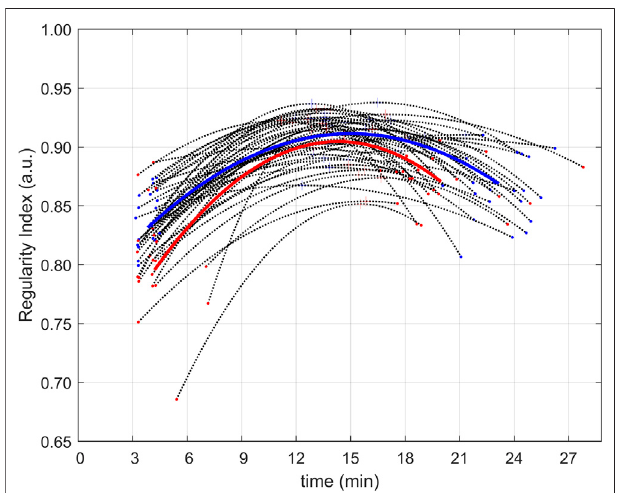
FIGURE 2 | Regularity pro fi les of all subjects. Regularity pro fi les (computed as second-order polynomials fi tting experimental data) for the 45 subjects (black dot lines with extremes and peaks, respectively, and dots and a plus (+) sign in red for untrained subjects and blue for trained ones). Average regularity pro fi les (in the form of second-order polynomials) are presented for the groups of untrained (red) and trained (blue)